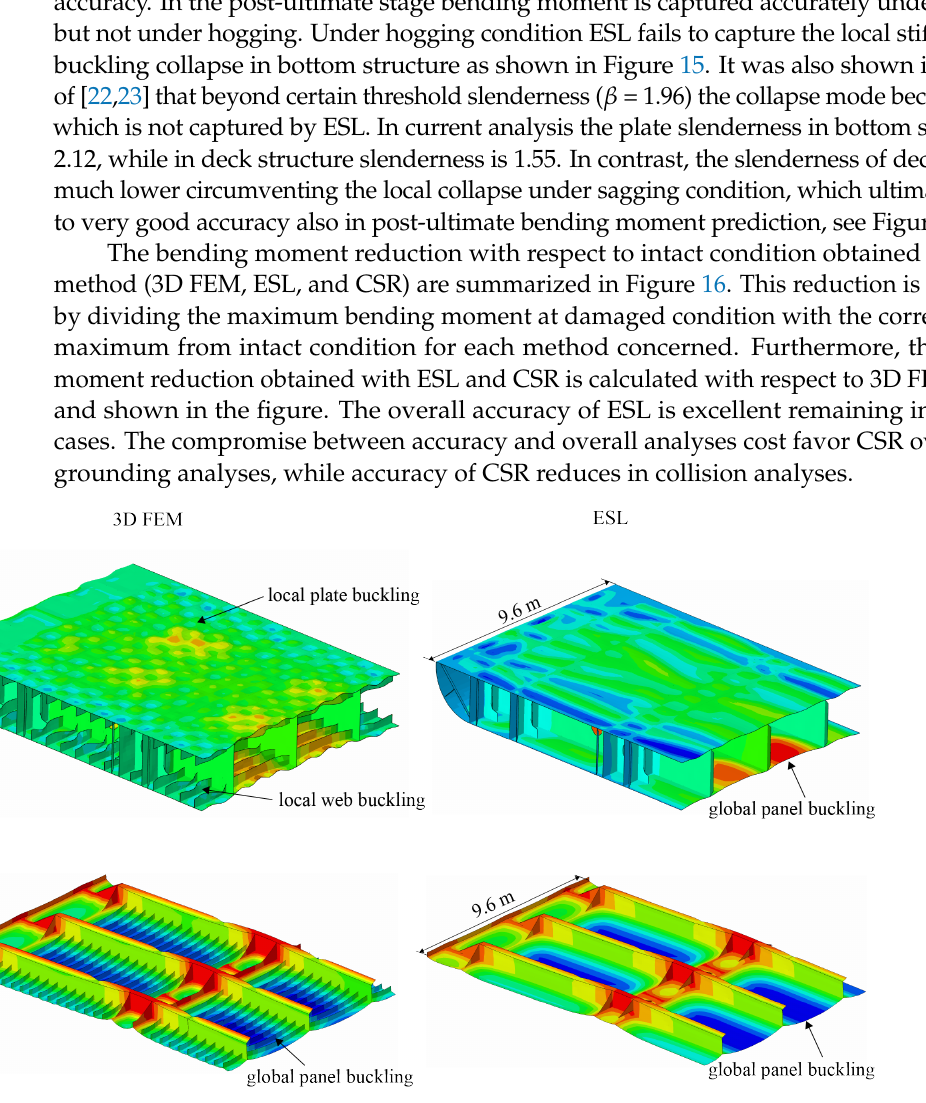
Figure 15. Collapse mode in double bottom and main deck structures under hogging and sagging conditions in post-ultimate stage, respectively. Deformation scaling factor is 5×.